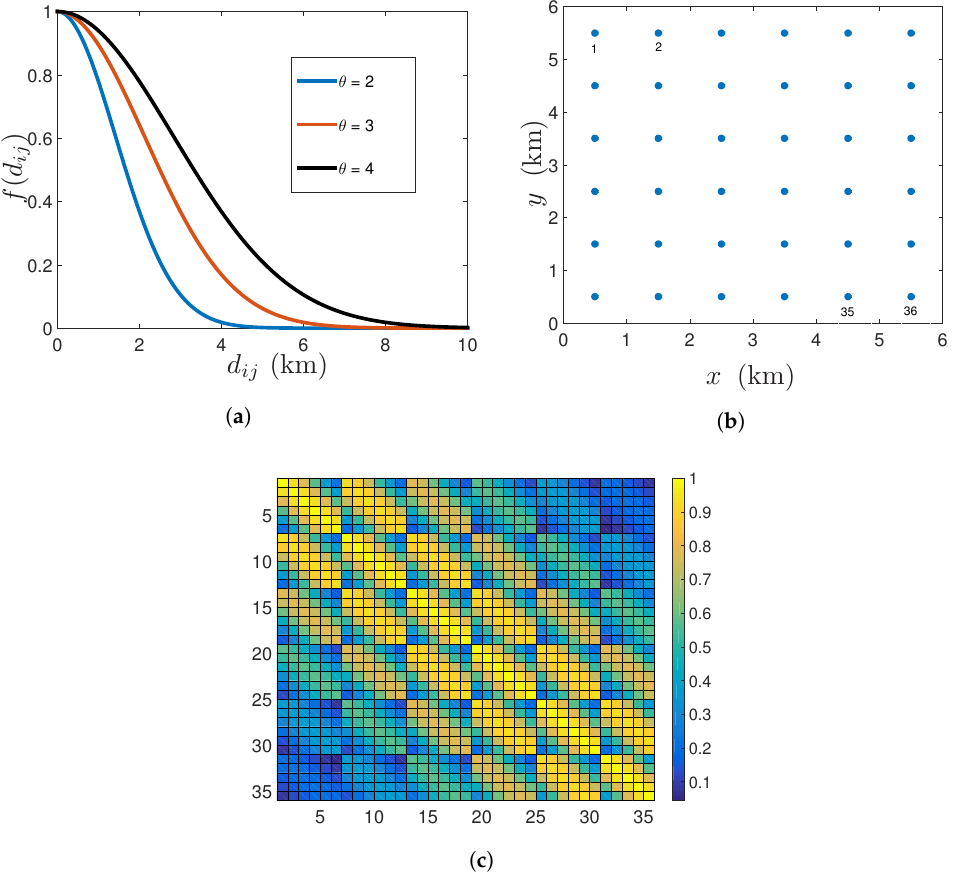
Figure 1. ( a ) Squared exponential covariance function for different values of θ (variance σ 2 s = 1); ( b ) Service area with N = 36 candidate sensing locations; ( c ) Spatial covariance